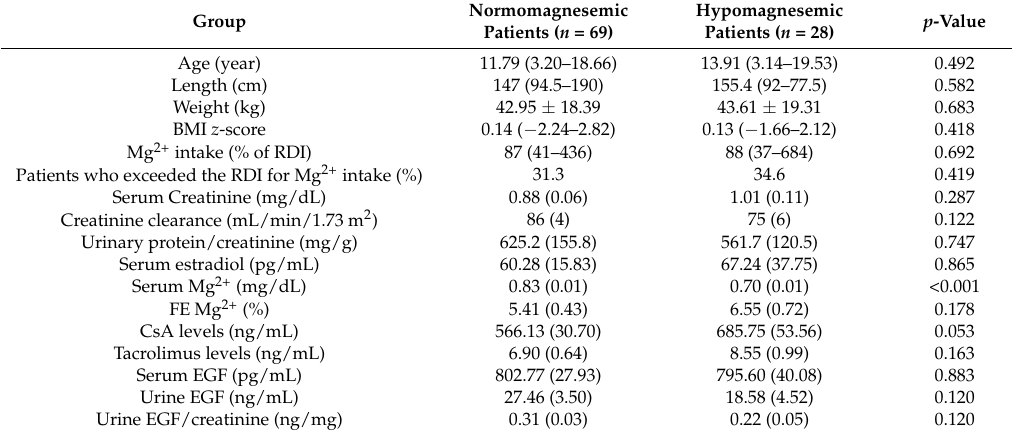
Table 3. Comparison of clinical and laboratory data between patients who developed hypomagnesemia and nomomagnesemic patients.